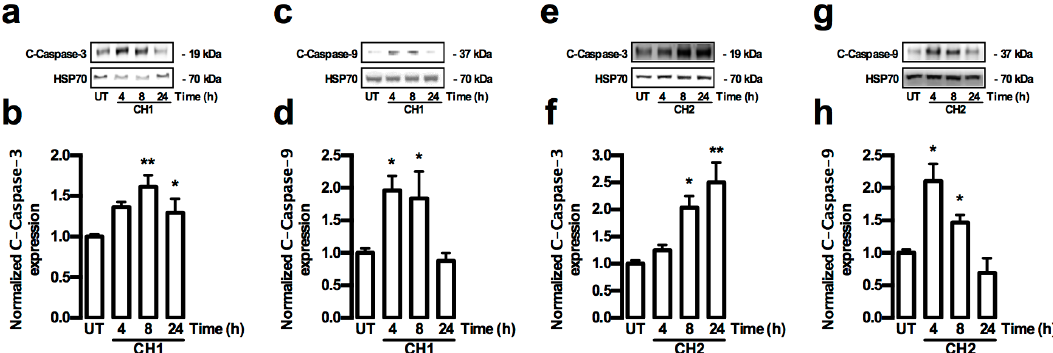
Figure 7. Chalcones-induced caspase intrinsic pathway in HepG2 cells. ( a – h ) Cells were treated with CH1 and CH2 (50 μ M, each) and protein expression was analyzed. ( a , c , e , g ) Representative images from Western blot experiments performed for the detection of C-caspase-9 and C-caspase-3; ( b , d , f , h ) Densitometric analyses of the experiments shown in ( a , c , e , g ), respectively. Protein levels were normalized against HSP70 and data are expressed relative to the UT (untreated) condition. Data are expressed as the mean ± standard error of the mean (SEM) from at least three independent experiments. Statistical differences were assessed by a one-way ANOVA (Kruskal–Wallis) followed by Dunn’s post hoc test. * p < 0.05; ** p < 0.01 vs. UT group.